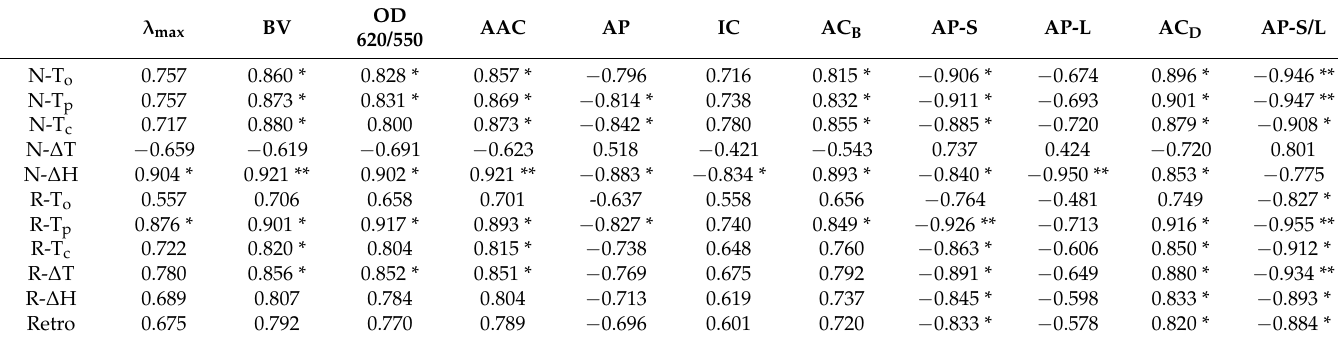
Table 5. Pearson correlation coefficients between molecular structural parameters and thermal properties of starches a